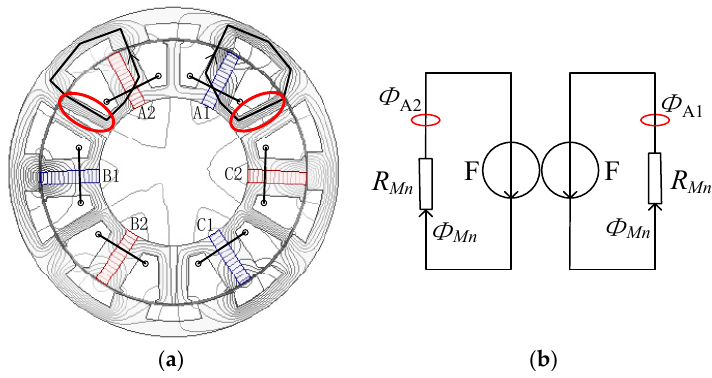
Figure 16. Negative extreme value of phase-A flux linkage produced by PMs in MSOR-FSPM motor: ( a ) No-load magnetic field distributions; ( b ) Local equivalent magnetic circuit.